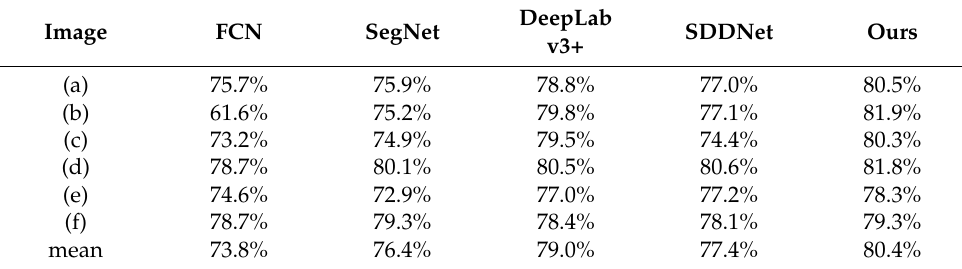
Table 4. Mean intersection over union